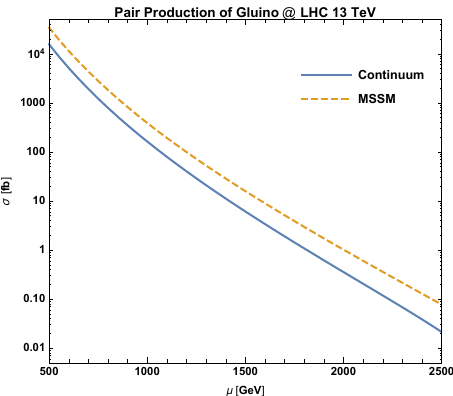
Figure 3. Typical KK gluino decay. Double-dash means o(cid:11)shell squarks.